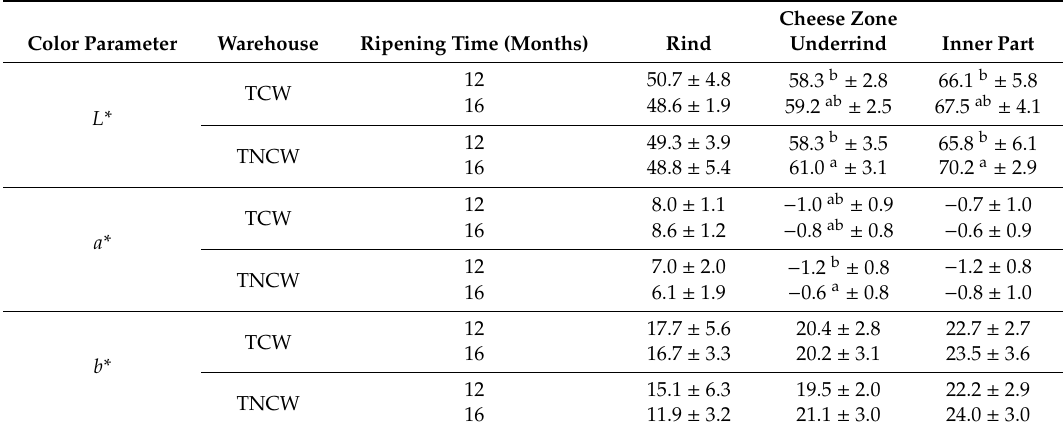
Table 3. Color parameters of Nostrano Valtrompia cheeses ripened for 12 and 16 months in temperature conditioned warehouse (TCW) and traditional non conditioned warehouse